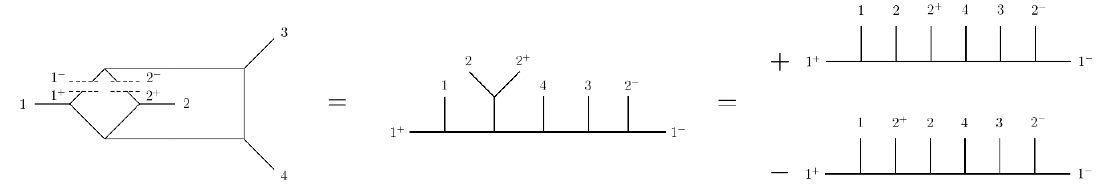
Figure 19 . Contribution to a non-planar double-box, and corresponding relation master diagrams.